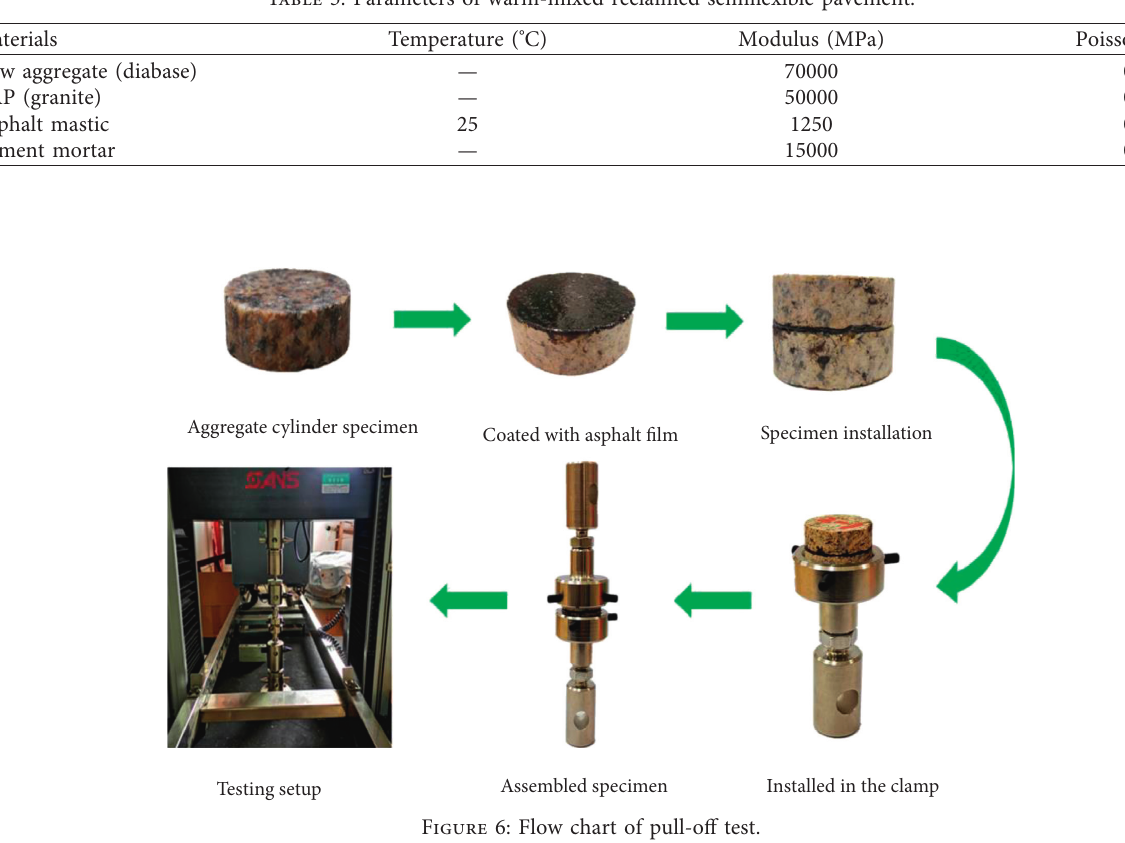
Figure 6: Flow chart of pull-off test.